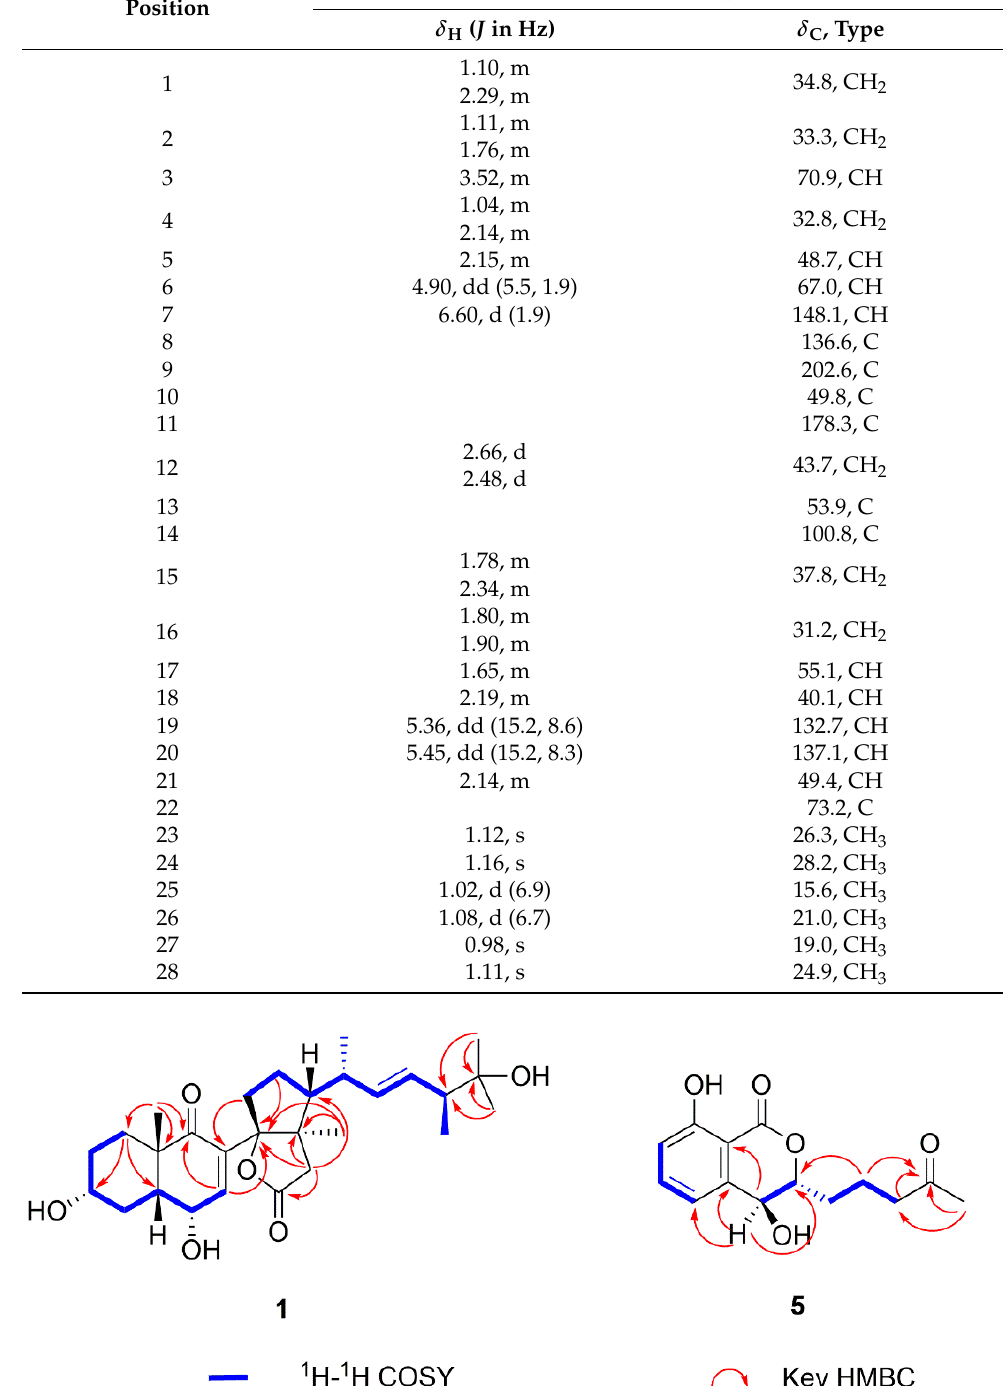
Figure 2. 1 H − 1 H COSY correlations and key HMBC correlations for compounds 1 and 5 .